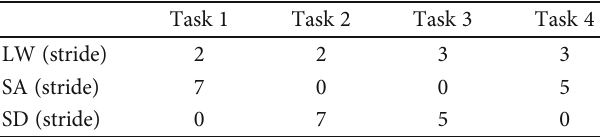
Table 1: The stride cycle number in each